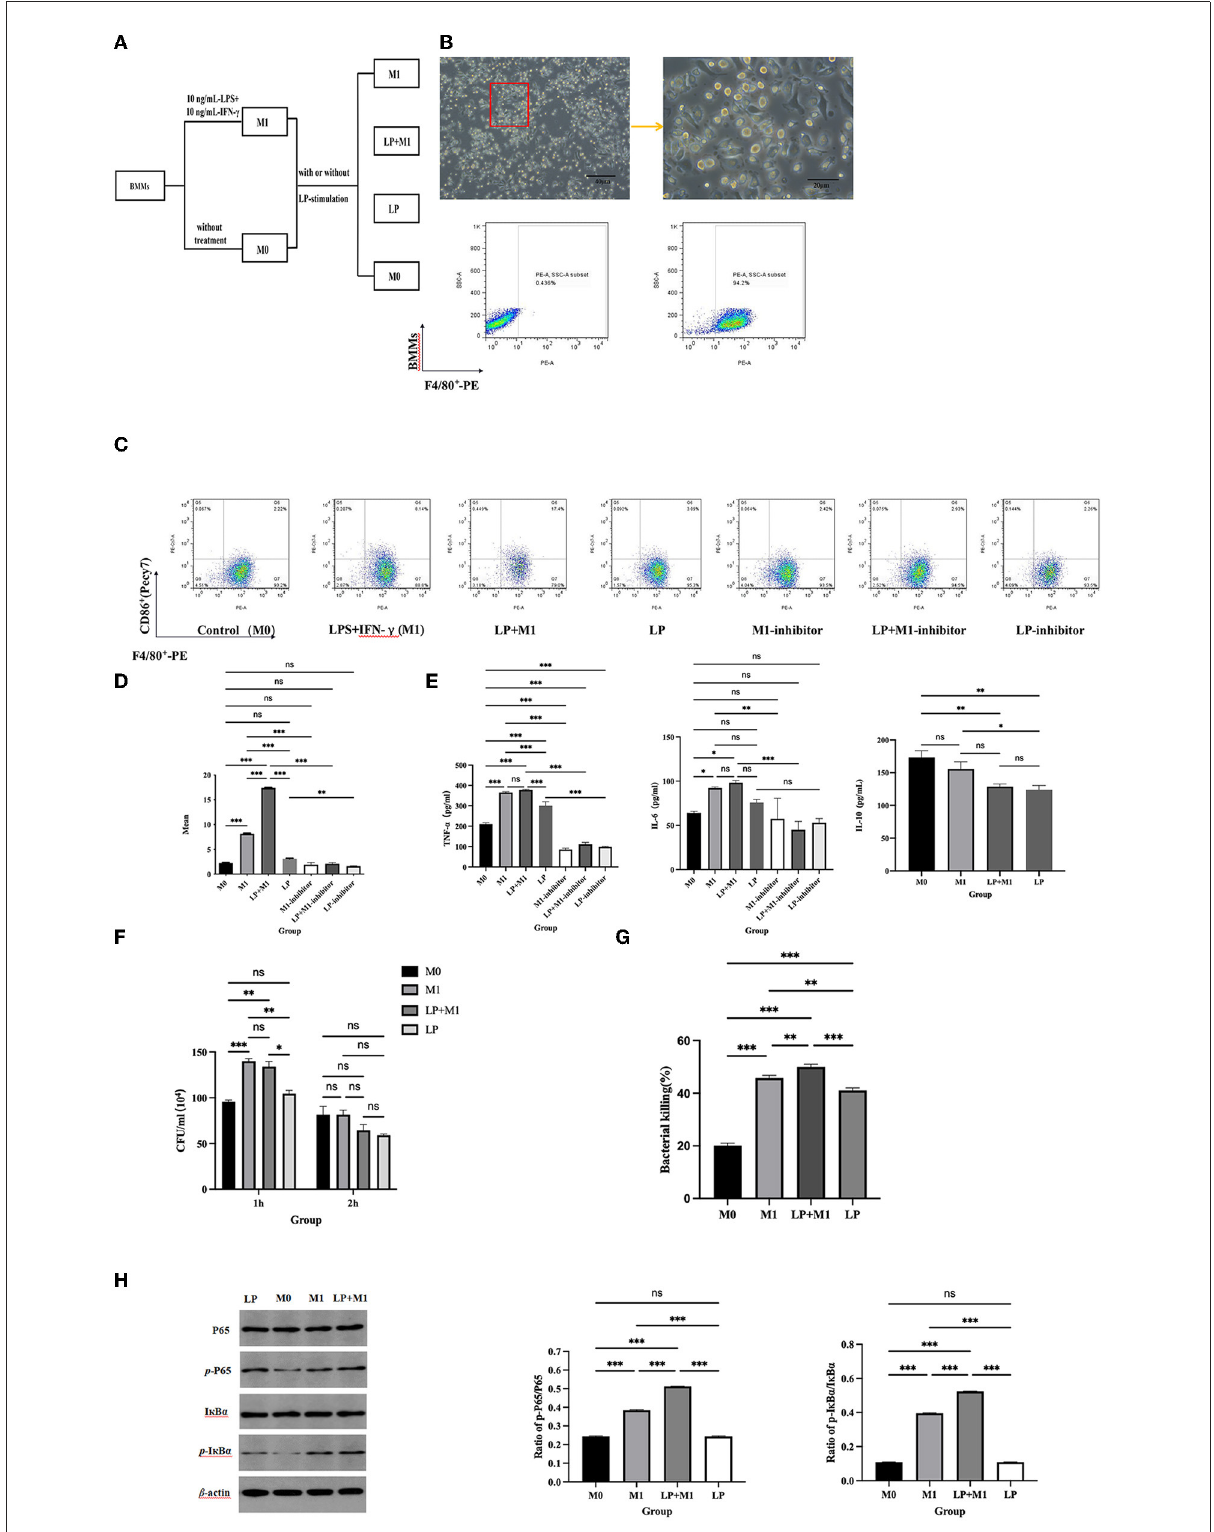
FIGURE3 LP synergistically promoted M1 macrophage polarization and BMMs function. BMMs (M0) were isolated from mouse bone marrow and induced to culture by 10ng/ml M-CSF for 7 days. BMMs were stimulated with 10ng/ml IFN- γ and 10ng/ml LPS (M1 inducer) for 12h. M0 and M1